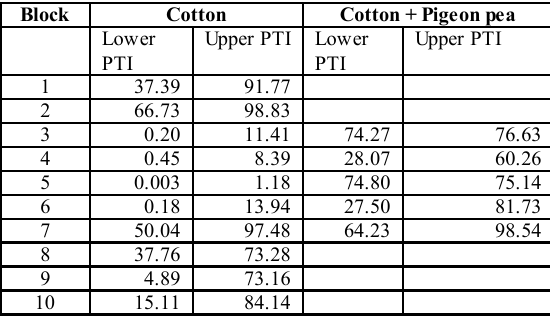
Table-2. Percent Tolerance Intervals (PTI) for cotton and cotton: pigeon pea (3:1) intercrop in western and southern zones 3.2.2. Accuracy of Crop maps : The overall accuracy levels (agreement between ground truth and imagery data) of mapping ranged from 82.4 (Block 10) to 98.9 % (Block 5). The mean accuracy was 95.44 ± 4.69(Mean ± SD). Crop Mapping: The range of host crops along with